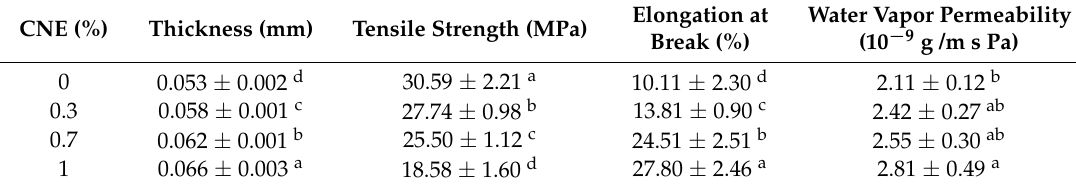
Table 1. Physical properties of adzuki bean starch (ABS) films containing various amounts of cocoa nibs extract (CNE).